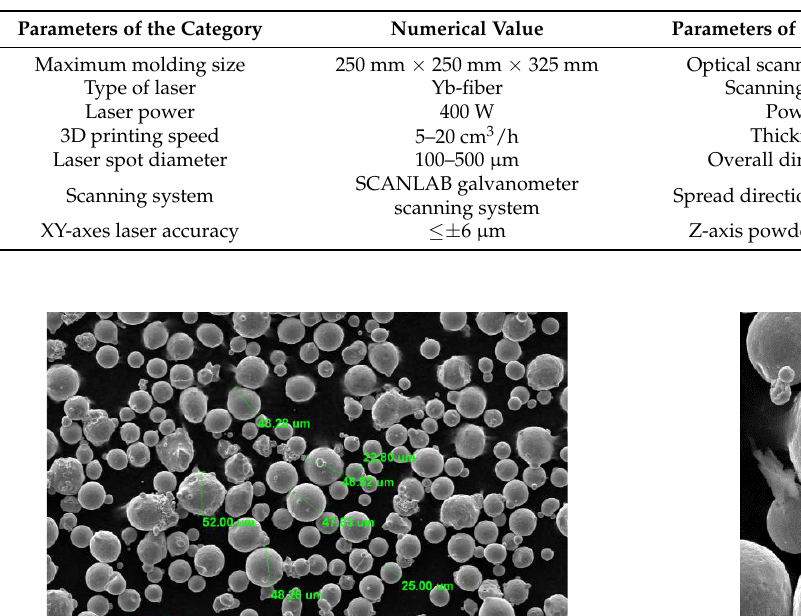
Table 1. Parameters of the EOS M290 metal additive manufacturing system.